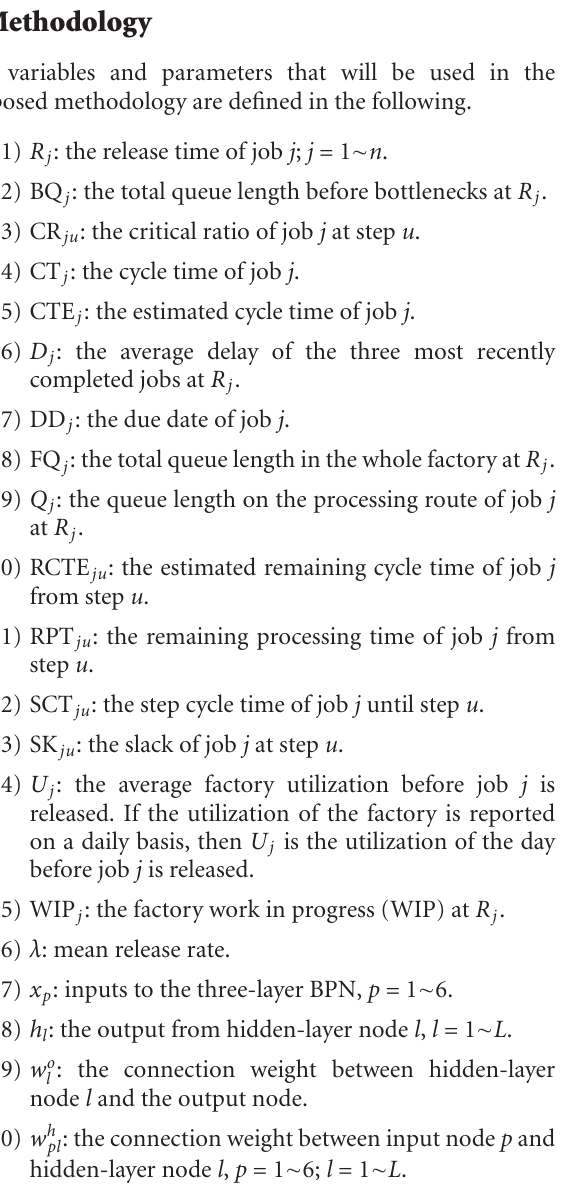
Table 1: The di ff erences between the proposed methodology and the previous methods. Number of adjustable Rule Number of objectives Objectives Optimized? How to derive the rule? parameters NFSMCT 1 Average cycle time Cycle time standard 1f-TNFSVCT 1 variation 1f-TNFSMCT 1 Average cycle time Cycle time standard 2f-TNFSVCT deviation Average cycle time, 4f-biNFS 2 cycle time standard deviation Average cycle time, The proposed 2 cycle time standard methodology